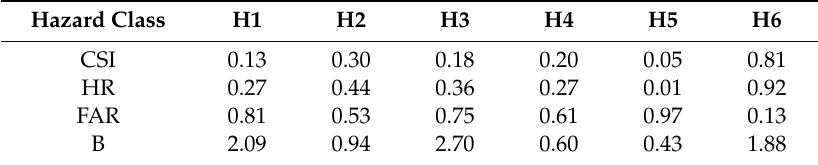
Table 5. Value of the performance indexes related to flooded areas extent of each hazard class (T = 200